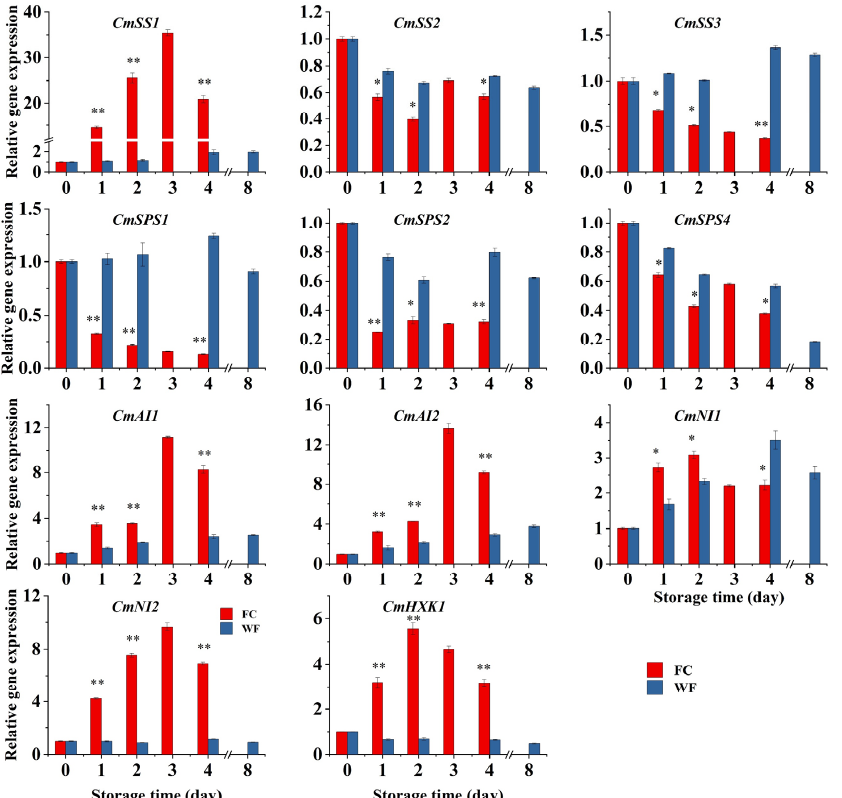
Figure 4. Effect of cutting on the relative gene expressions of sucrose synthase ( CmSS1/2/3 ), sucrose phosphate synthase ( CmSPS1/2/4 ), acid invertase ( CmAI1 /2), neutral invertase ( CmNI1 / 2 ), and hexokinase ( CmHXK1 ) in melon fruit during storage (15 °C). FC and WF respectively represent fresh-cut and whole melon fruit. The values are expressed as means ± SE of three replicates. * and ** indicate statistically significant differences ( p < 0.05 and p < 0.01 respectively) according to Student’s t -test at each sampling point.